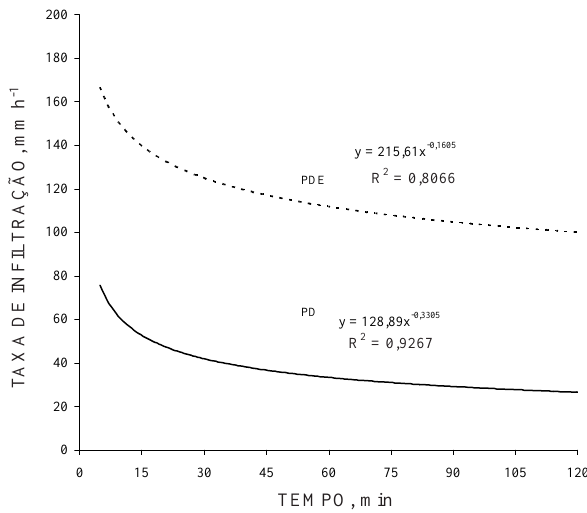
Figura 4. Condutividade hidráulica do solo saturado na camada superficial do solo, sob plantio direto (PD) e plantio direto escarificado, determinada 12 meses após a escarificação.